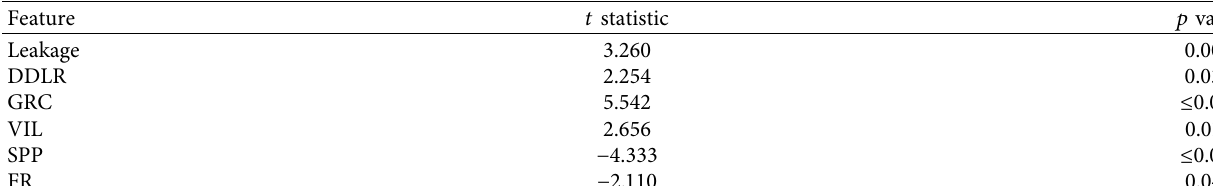
Table 4: Correlation coefficient significance test.